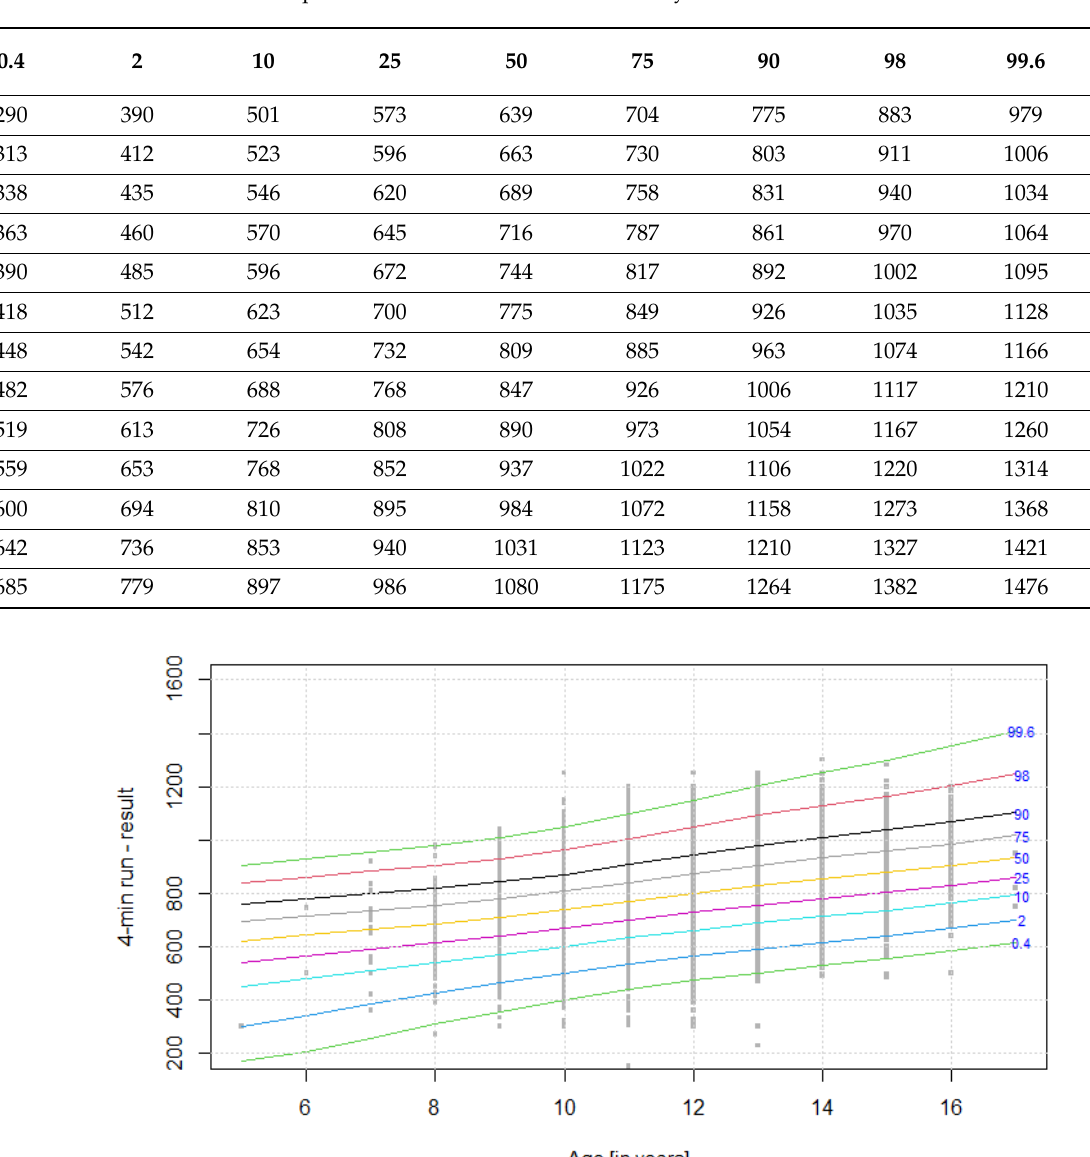
Table 10. Values of particular centiles for 4-min run in boys.